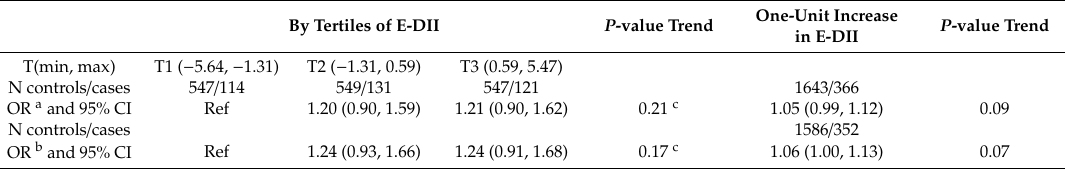
Table 2. Odds ratios and 95% confidence intervals of CLL according to E-DII among 1643 CLL controls and 366 CLL cases in the MCC Spain study.